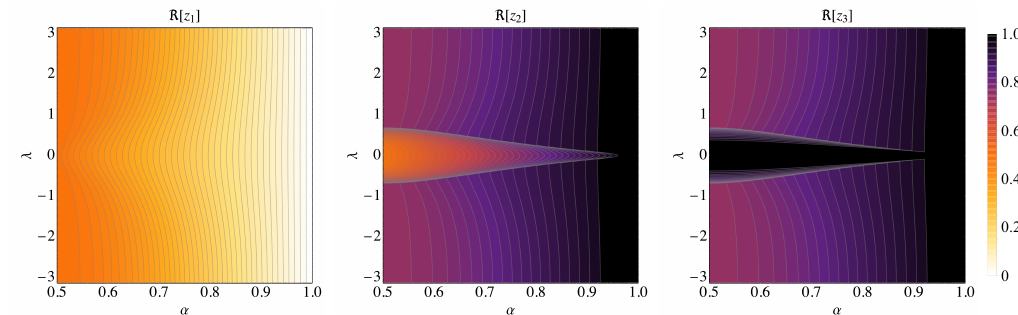
of the transfer ma- j